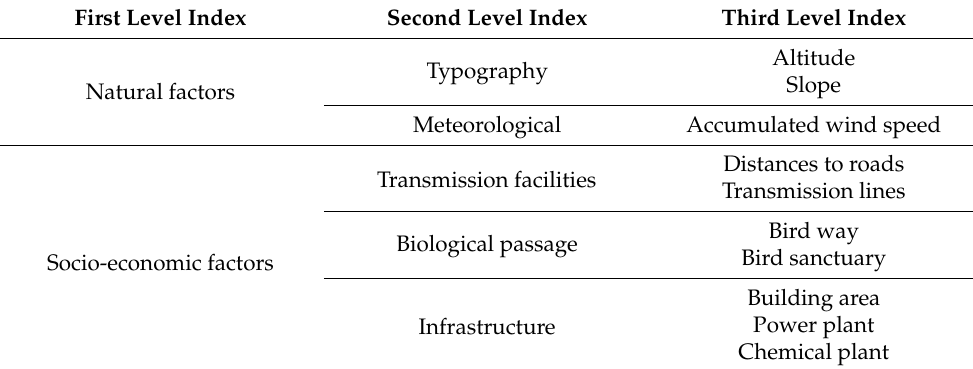
Table 1. Index system for finding the optimal location of wind